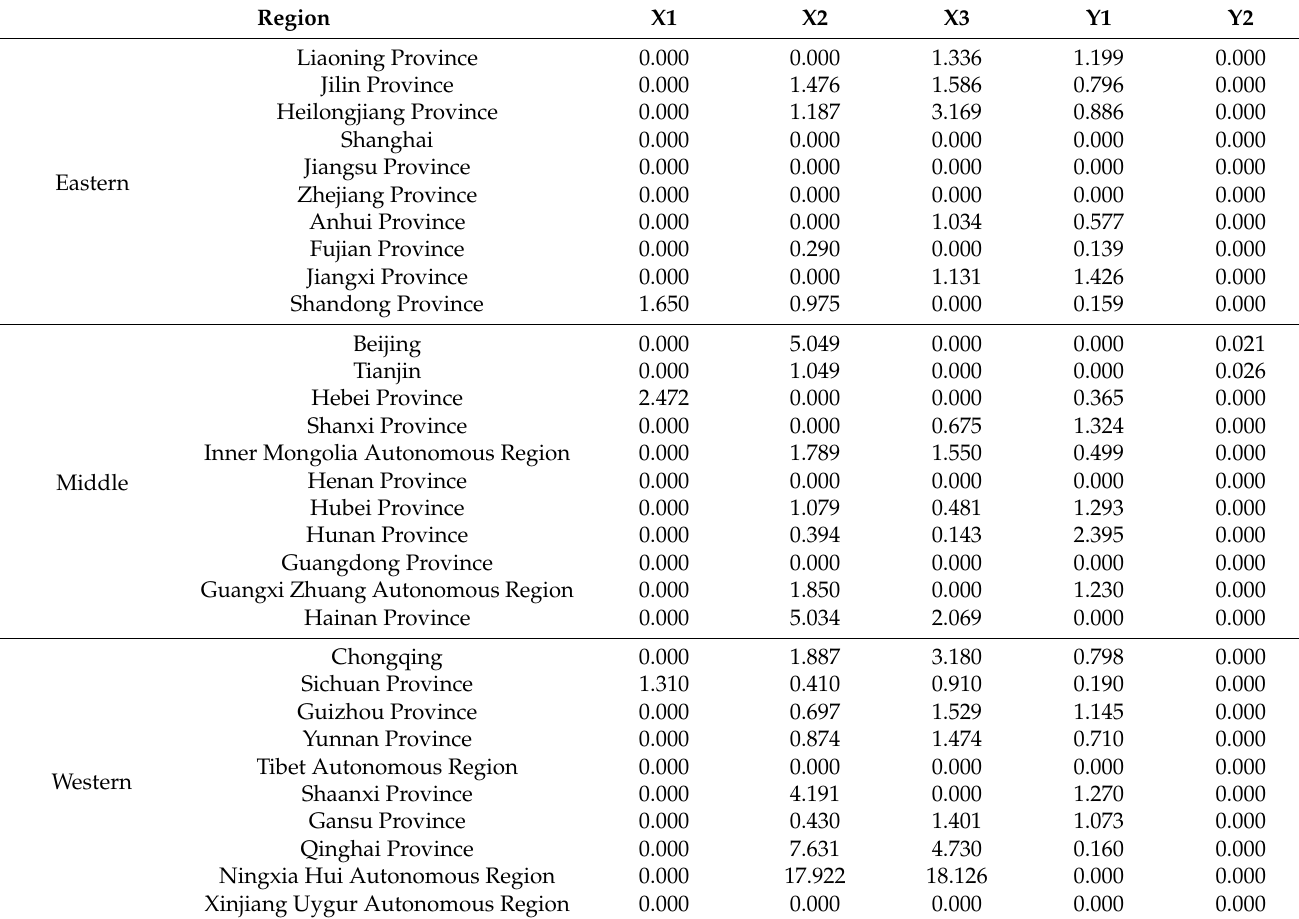
Table 3. Values of medical resource relaxation